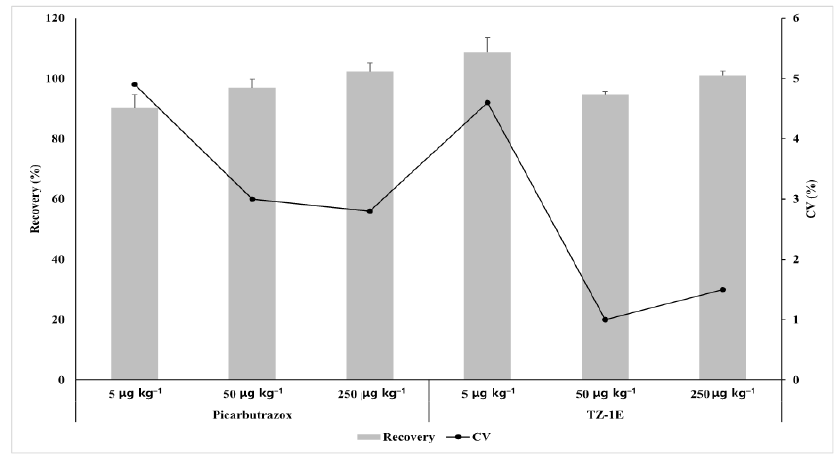
Figure 1. Average recovery with standard deviation (n = 3) and coefficient of variation (CV) of picarbutrazox and TZ-1E in Chinese cabbage at different fortification levels.